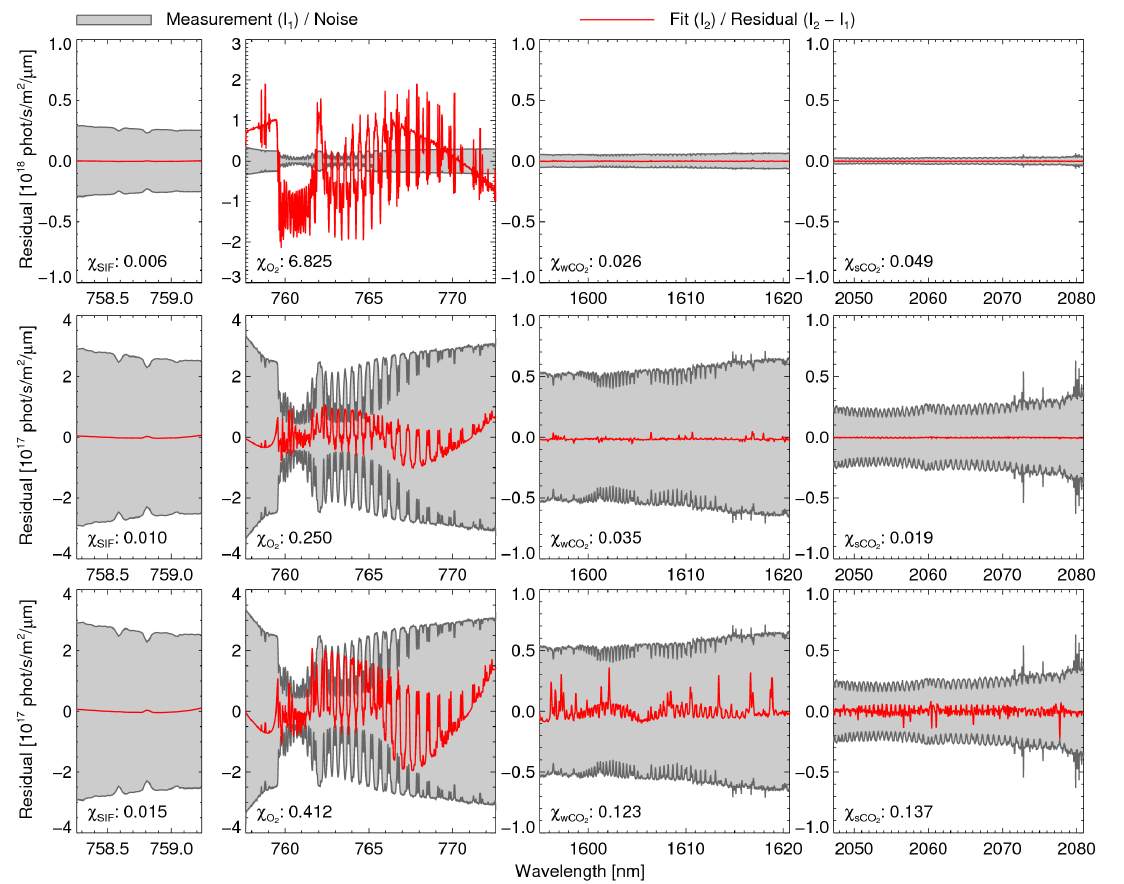
Figure 8. As Figure3 (bottom) but for the Rayleigh scenario and the 0-Scat setup ( top ), the Rayleigh scenario and the 3-Scat setup ( middle ), and the Rayleigh+AerosolBG+Watercloud scenario and the 3-Scat setup ( bottom ).